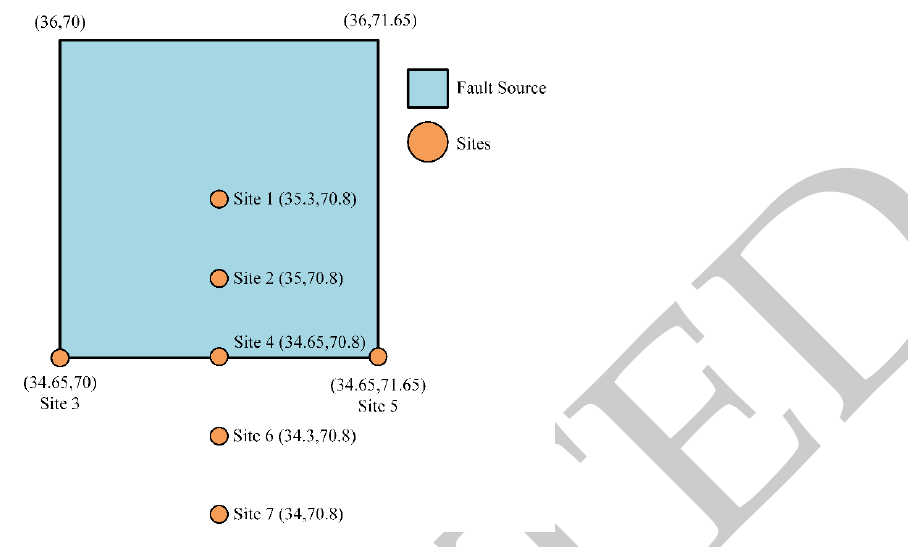
Table 3. Area source-based test case details.